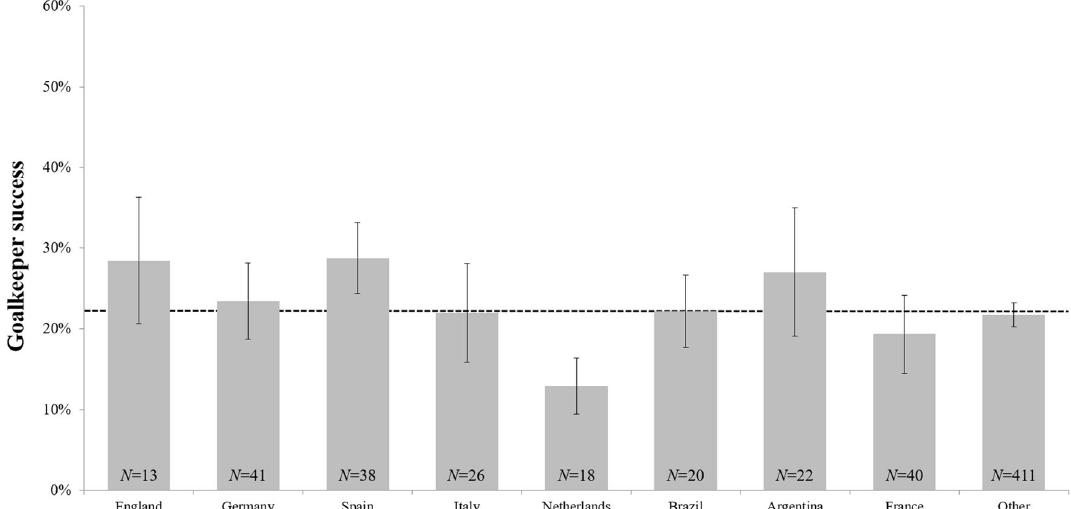
Figure 3. Mean percentages of the goalkeeper success ratios for penalty kicks faced (shootouts and in-game) during World Cup, European Championship, Champions League and Europa League matches as a function of goalkeeper nationality. The N ’s refer to the number of goalkeepers analyzed for each nation (597 of 2379 penalty kicks were missed against 629 different goalkeepers in the analyzed time periods). Error bars represent standard errors of the